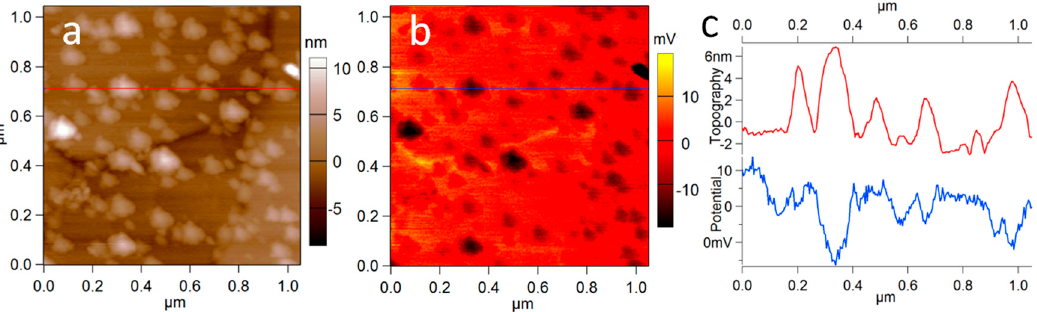
Figure 3. SKPM measurement of commercial (oxide-free) Au NPs on silicon. ( a ) Topography image; ( b ) surface potential image; ( c ) cross-sections at the horizontal red line in ( a , b ).